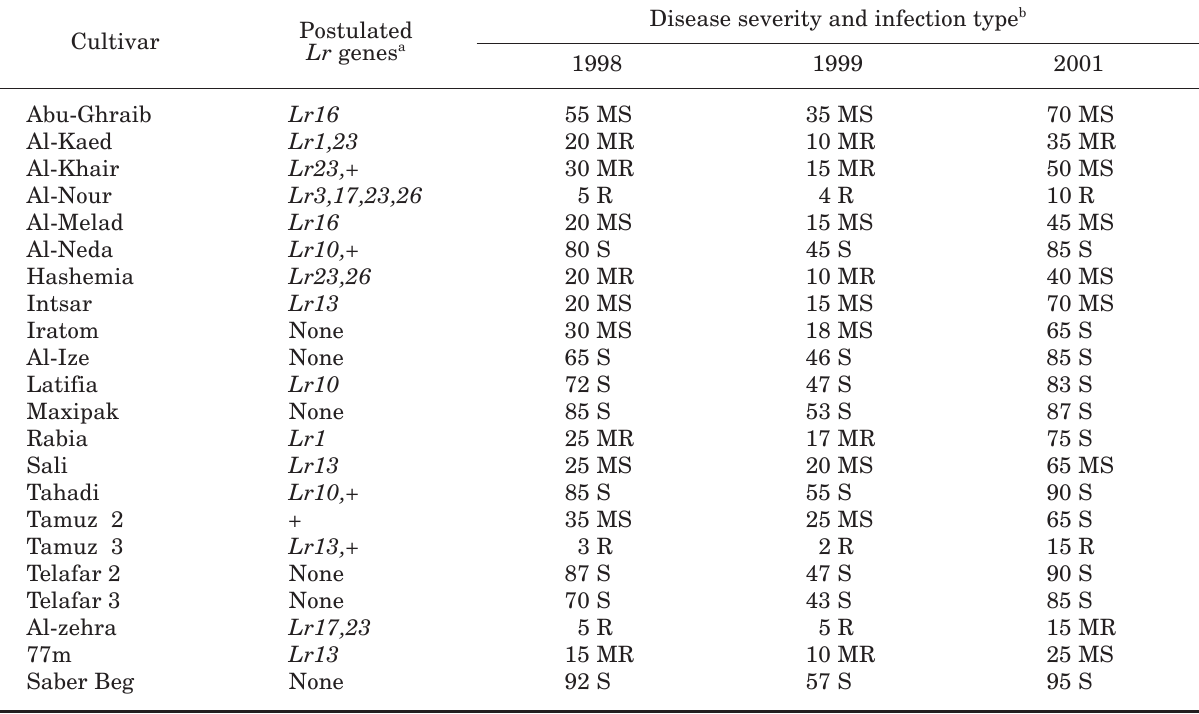
Table 4. Disease severity and reaction caused by P. triticina on Iraqi wheat cultivars at the adult-plant stage during 1998 to 2001 at the Twaitha Experimental Station, Baghdad,